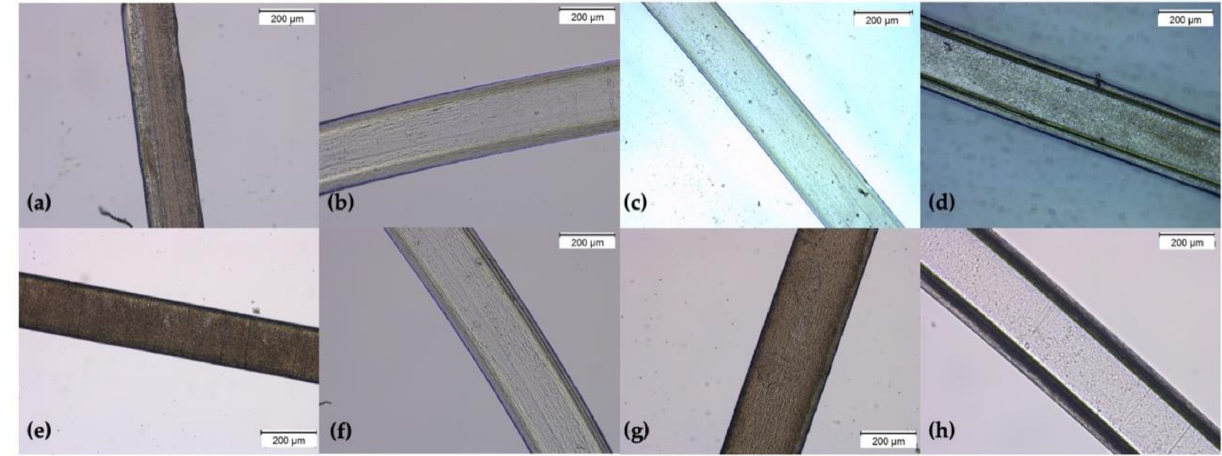
Figure 2. Micrographs of the unloaded and loaded wet-spun fibers ( a ) SA, ( b ) SAGN, ( c ) SAGNCL and ( d ) GNCL, ( e ) SAz, ( f ) SAGNz, ( g ) SAGNCLz, ( h ) GNCLz, captured at 10 × magnification using a brightfield microscope. The appearance of a coating-like layer surrounding the fibers is due to the microscope inability to perceive 3D structures, without losing